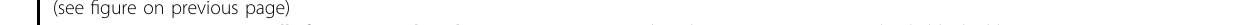
Fig. 3 HS-1371 protects cells from TNF-induced necroptosis. a TNF-induced necroptosis was completely blocked by HS-1371 treatment. HT-29 cells were pretreated with four tested inhibitors for 2 h and then treated with TSZ (6 h for immunoblotting, 24 h for cell death assay). Cell lysates were analyzed by immunoblotting, and cell viability was analyzed by MTT assay or phase-contrast microscopy. The results are presented as the means ± SEM. * P < 0.05, ** P < 0.01, *** P < 0.001. b Protection of necroptosis by HS-1371 treatment is similar with dabrafenib, which abolished downstream events. HT-29 cells were pretreated with various necroptosis inhibitors and HS-1371 before TSZ treatment. Cell lysates were analyzed by immunoblotting, and cell viability was analyzed by MTT assay (left panel). Cells were stained with phospho-MLKL antibody and analyzed by confocal fl uorescence microscopy (middle panel), and cell death was further analyzed by FACS analysis after PI staining (right panel). c HS-1371 protects cells from TNF-induced necroptosis in a dose-dependent manner. HT-29 cells were pretreated with indicated concentrations of HS-1371 and then treated with TSZ (6 h for immunoblotting, 24 h for cell death assay). Cell lysates were analyzed by immunoblotting, and cell viability was analyzed by MTT assay or phase-contrast microscopy. The results are presented as means ± SEM. * P < 0.05, ** P < 0.01, *** P <